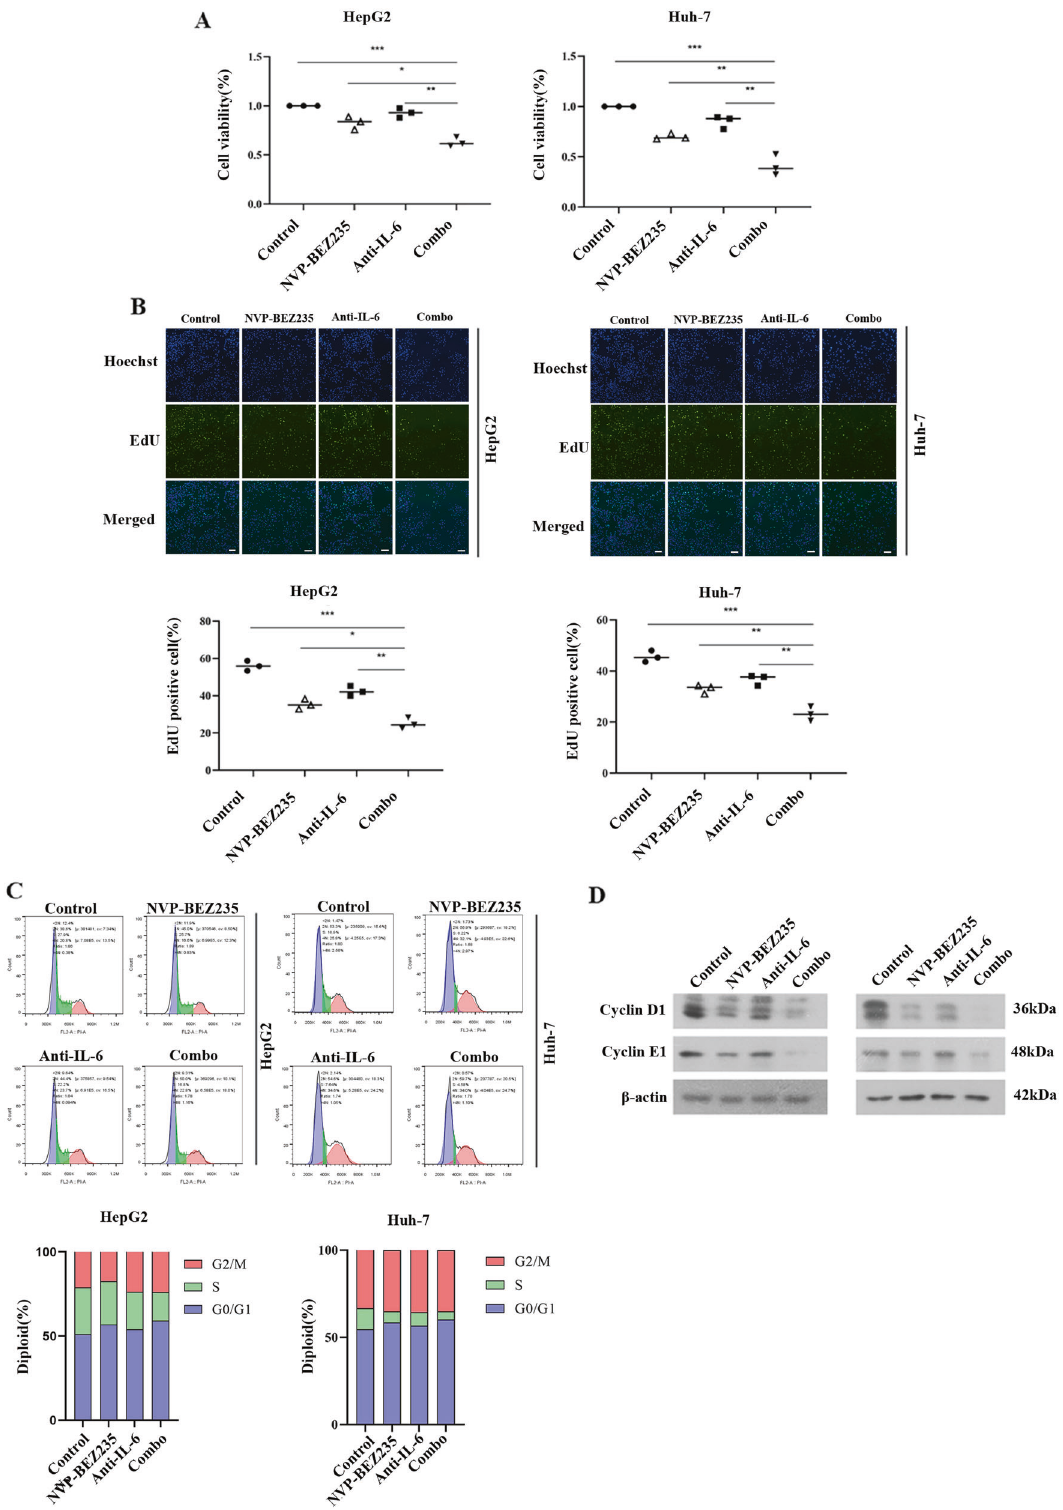
Fig. 4 IL-6 blockade increases NVP-BEZ235-induced inhibition of cell viability in HCC cells. A Cell proliferation rates of HepG2 and Huh-7 cells treated with NVP-BBEZ235, anti-IL-6 Ab, or their combination for 24 h via CCK-8 assay. B The effects of NVP-BBEZ235, anti-IL-6 Ab, or their combination on the proliferation of HepG2 and Huh-7 cells for 24 h via EdU staining assay. C Cell cycle pro fi les of HepG2 and Huh-7 cells treated with NVP-BBEZ235, anti-IL-6 Ab, or their combination for 24 h via fl ow cytometry analysis. D Cyclin D1 and cyclin E1 protein expression was detected by western